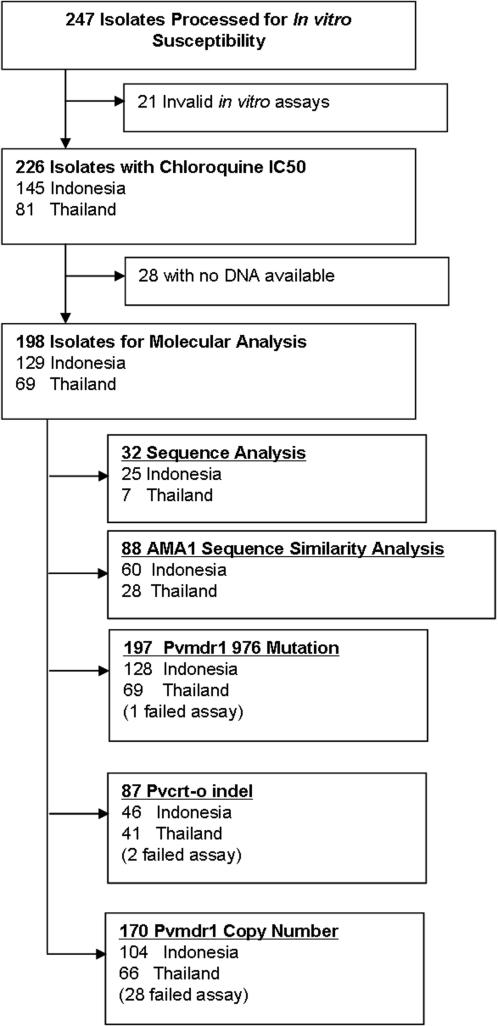
The selection of samples analysed.